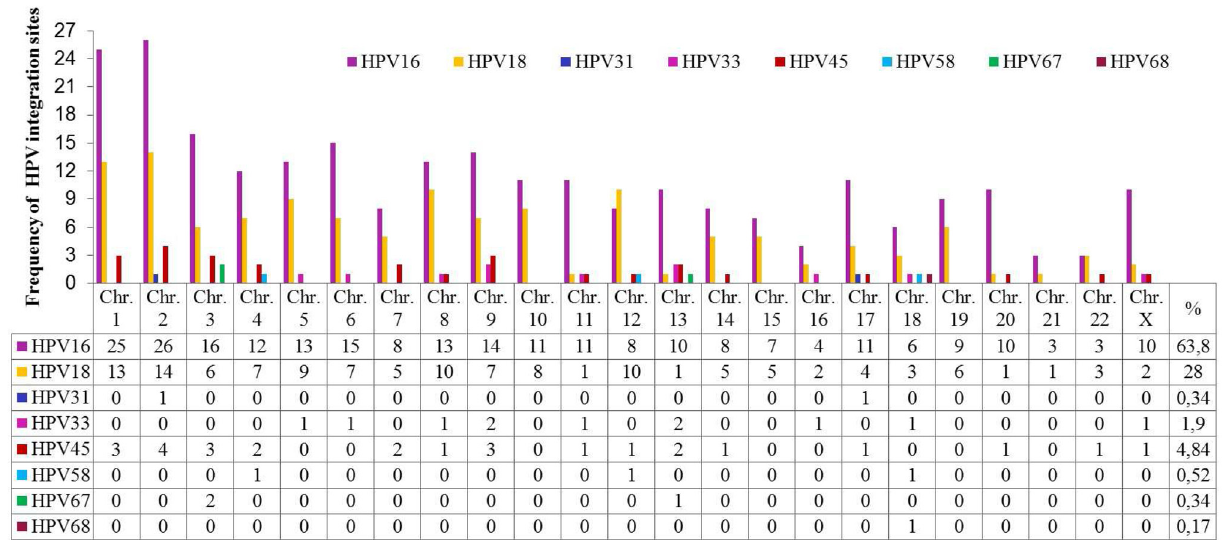
Figure 2. Chromosomal distribution of integration sites of HPV types (HPV 16, 18, 31, 33, 45, 58, 67 and 68) most frequently reported in the literature.